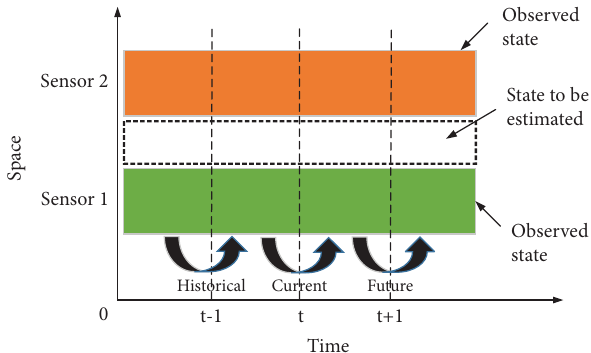
Figure 1: Illustration of trafc state estimation considers the spatial-temporal